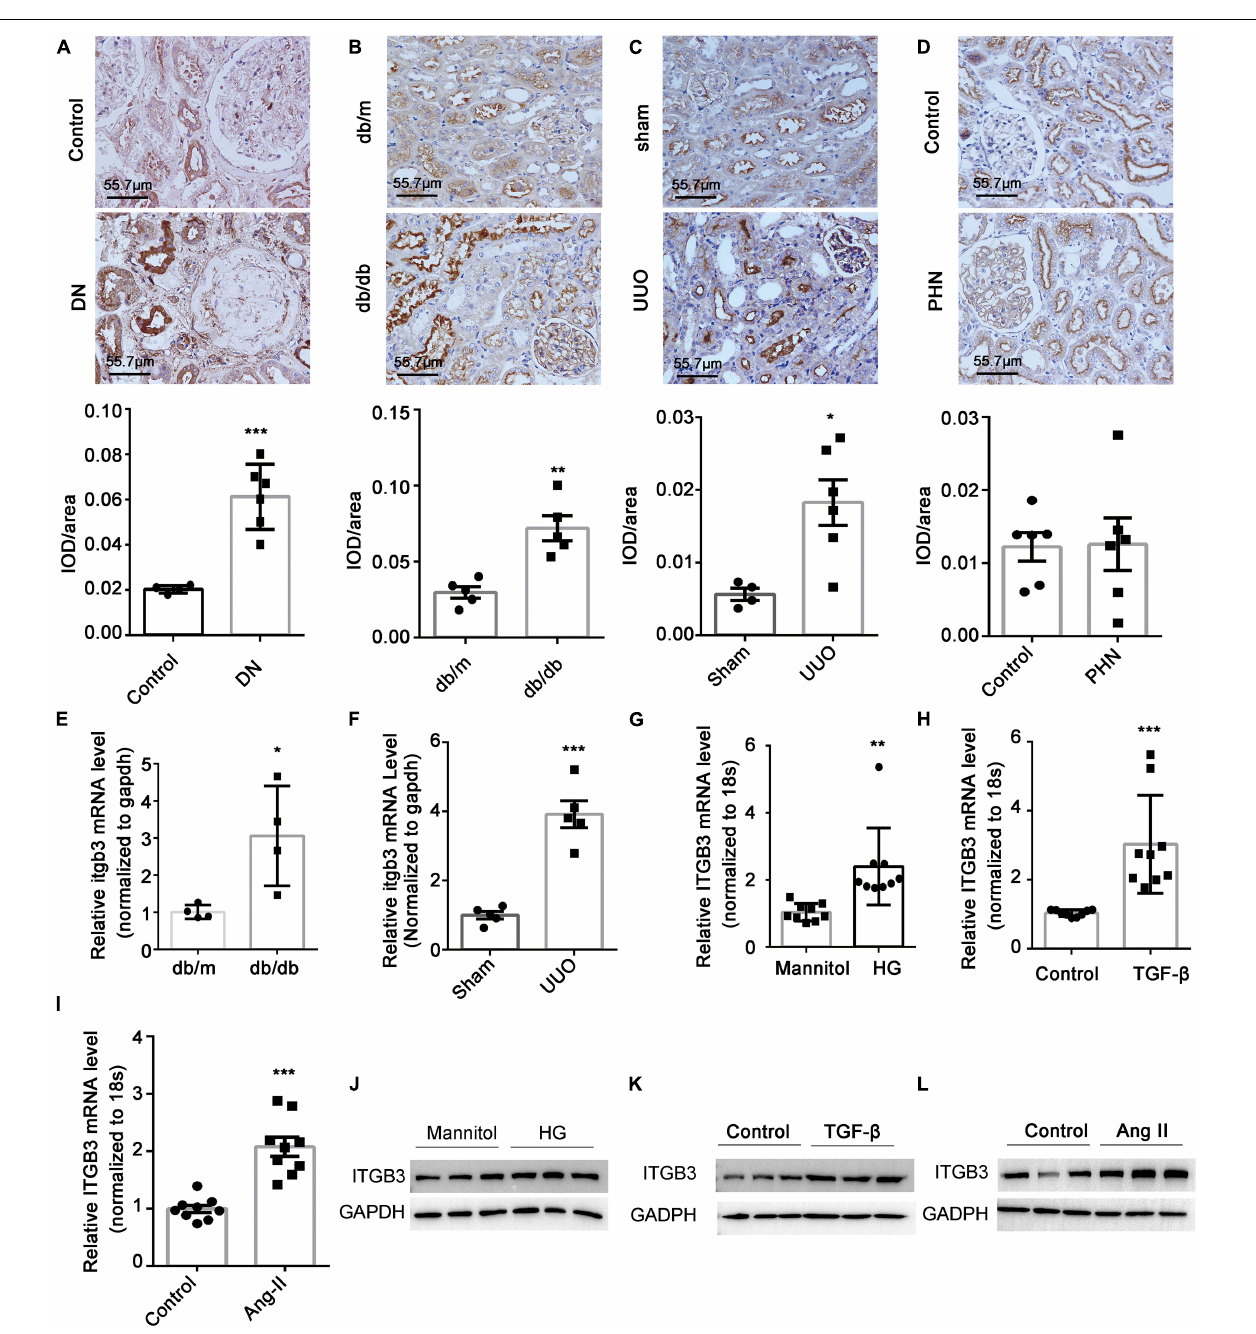
FIGURE 3 | Expression of ITGB3 in tubular tissues in kidney disease. IHC and quantification analysis of ITGB3 in (A) patients with DN ( n = 6 per group) and animal models ( n = 5 per group) of (B) db/db, (C) UUO, and (D) PHN. The level of Itgb3 mRNA in tubular tissues of (E) db/db and (F) UUO mice. The level of ITGB3 mRNA in HK-2 cells treated with (G) high glucose (30 mM, 24 h), (H) TGF- β (10 µ g/ml, 24 h), and (I) Ang II (1 µ M, 24 h). The level of ITGB3 protein in HK-2 cells treated with (J) high glucose (30 mM, 48 h), (K) TGF- β (10 µ g/ml, 48 h), and (L) Ang II (1 µ M, 48 h). Data shown are representative of three experiments. For statistical analysis, a two-tailed Student’s t -test was used for panels (A–I) . *** p < 0.001. ** p < 0.01. * p < 0.05. Scale bar = 55.7 µ